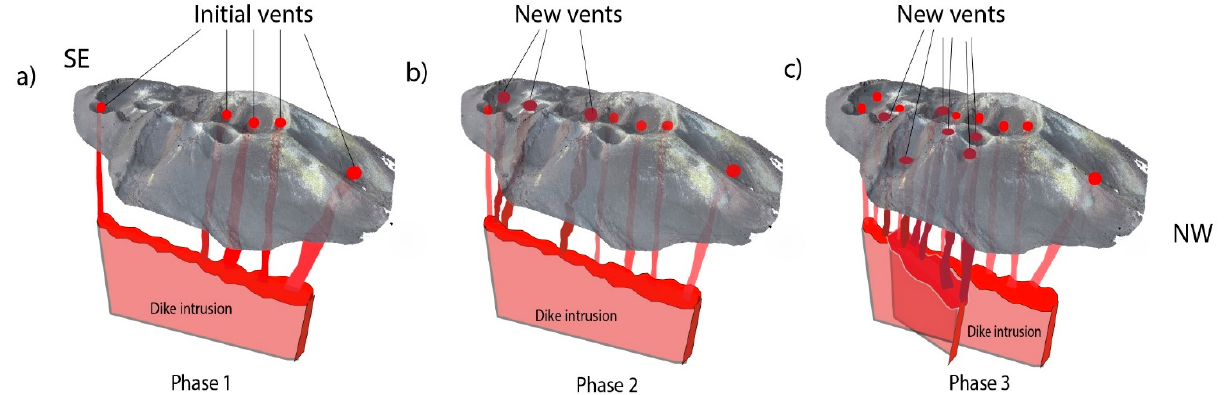
Figure 7. Conceptual model of the 2021 Cumbre Vieja Eruption. ( a ) Phase 1 of the eruption shows craters aligned on the NW flank with a single crater on the SE side. ( b ) Phase 2 shows a new intrusion on the SE side with several new craters opening, producing two separate groups of craters. ( c ) Phase 3 shows disaggregation of new open craters in the NE and SE flanks, possibly associated with a new dike intrusion oblique to the main one. The post-eruption UAS DEM was used for the cone visualization, which is why the position of some craters does not coincide with the vent locations.